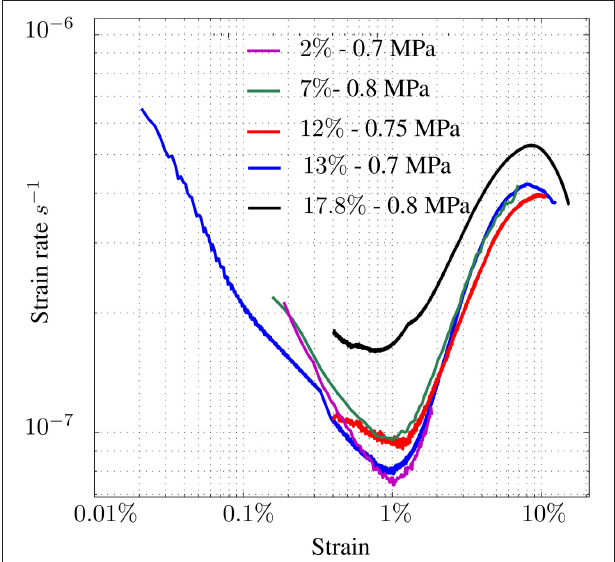
FIGURE 1 | Strain rate vs. strain plots for the different tests performed. Imposed stress varied between 0.7 and 0.8 MPa. Temperature was − 5 ◦ C ± 0.5 ◦ C. Strain data were acquired by Digital Image Correlation method (DIC) or using a Low Voltage Displacement Transducer (LVDT).